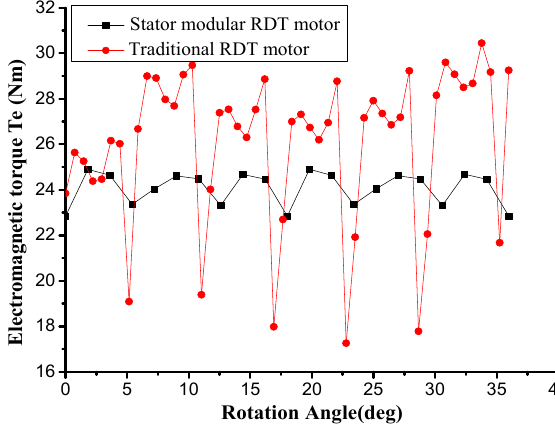
Figure 9. Harmonic analysis of the phase back–EMF.